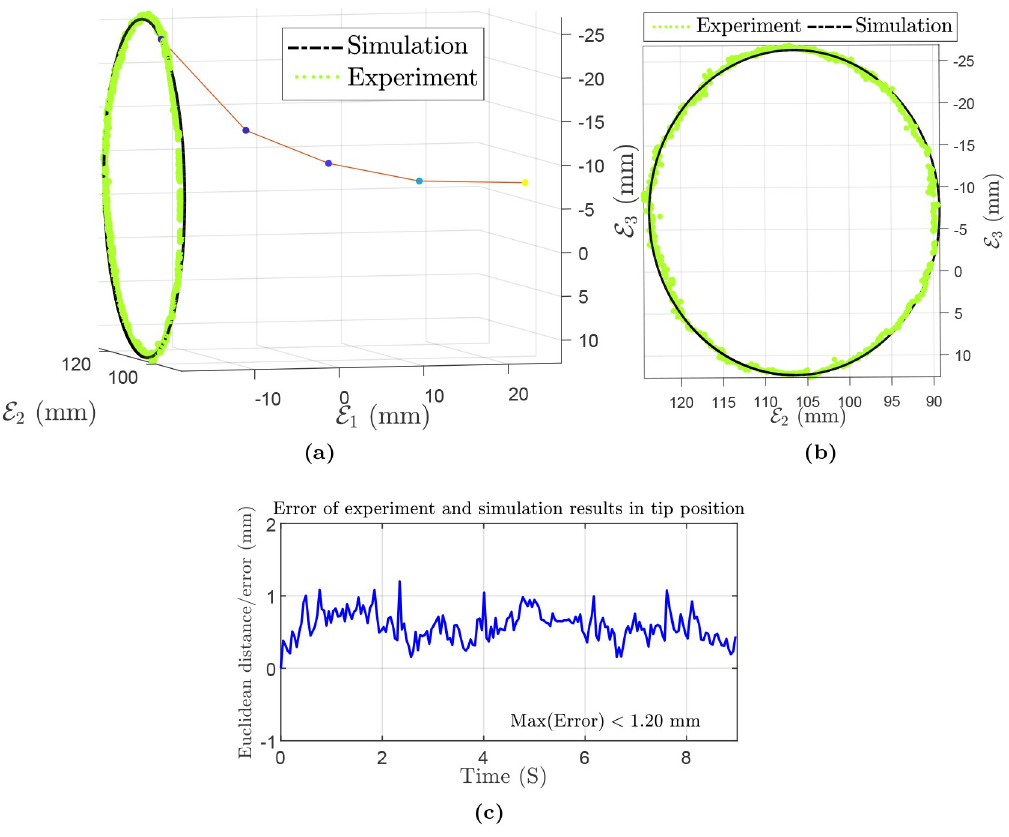
Fig 13. Reconstruction of the scene for circular motion of Polydimethylsiloxane (PDMS) rod with an embedded magnet at the tip: (a,b) 3D experiment and simulation results. (c) Euclidean distance/error of experiment and simulation results in tip